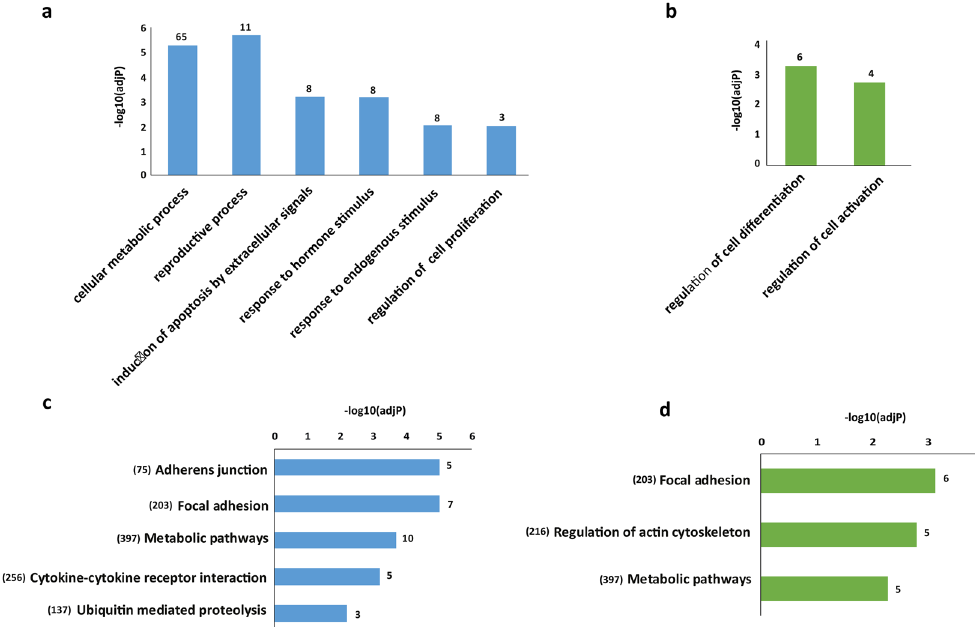
Figure 4. The GO and KEGG pathway analysis of DE lncRNAs co-located genes in primary monocytes of XLA patients compared to healthy subjects. The significant GO biological process terms enriched for ( a ) DE annotated lncRNAs co-located genes, and ( b ) DE novel lincRNAs co-located genes. The number of DE lncRNAs co-located genes enriched in each GO terms is depicted above the bars in the figure. The significant KEGG pathway terms enriched for ( c ) DE annotated lncRNAs co-located genes, and ( d ) DE novel lincRNAs co-located genes. Each statistical significance value (adj.p-value) was negative log-10 base transformed. The numbers in the brackets indicate the total numbers of genes available in the KEGG database for each pathway terms. The number of identified DE lncRNAs co-located genes enriched in each KEGG pathways is depicted above the bars in the